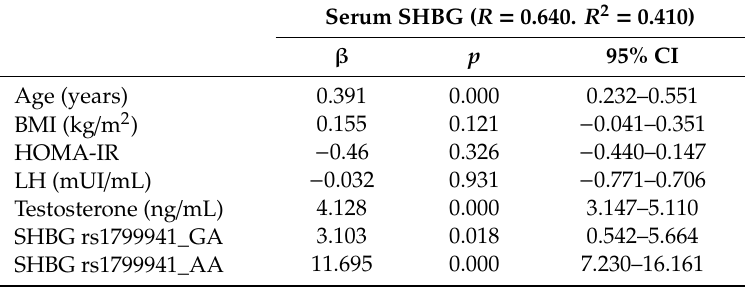
Table 4. Lineal regression analysis with serum SHBG levels as dependent variable, and age, BMI, HOMA-IR, LH, testosterone and the polymorphism variants of the SHBG rs1799941 as independent parameters.